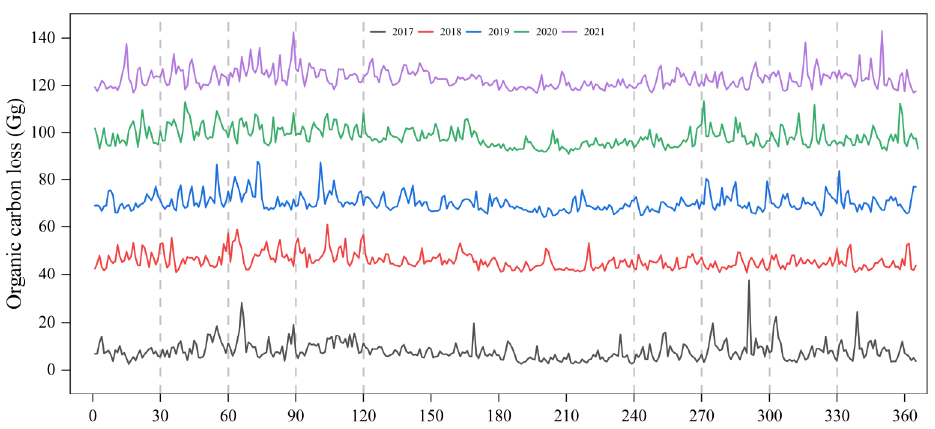
Figure 6. Global daily loss of organic carbon from farmland, 2017–2021. Note: 1-365 or 366 for January 1st to December 31st of each year.